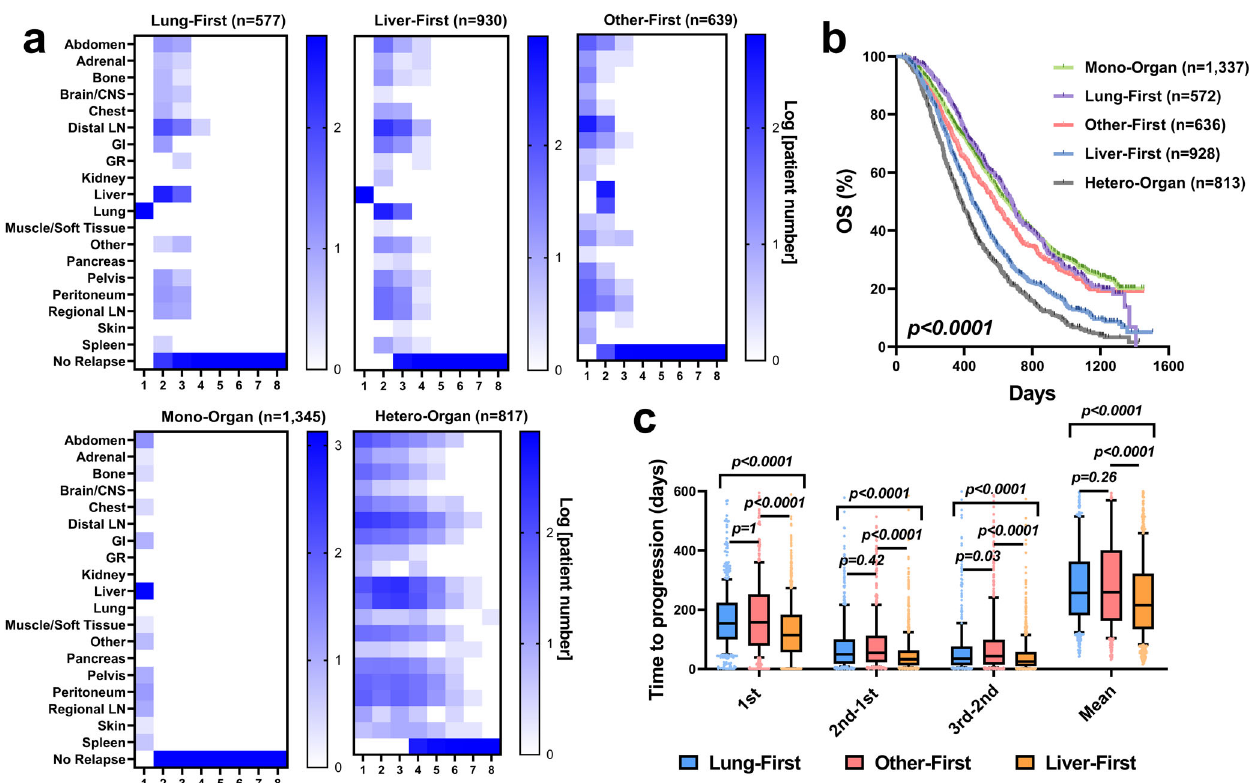
Fig. 4 | Patient progression sequence association with patient survival. a Patients were clustered into fi ve groups based on their lesion progression sequence. The column labels are the progression sequence. Color of the heatmap represents the log10 scale of patient number (all plus one to avoid zero values). b Kaplan-Meier curves ofclustered patients overall survival. c Boxplots of the fi rst lesion progression time (1st), time between fi rst and second progression (2nd-1st), time between second and third progression (3rd-2nd), time between third and